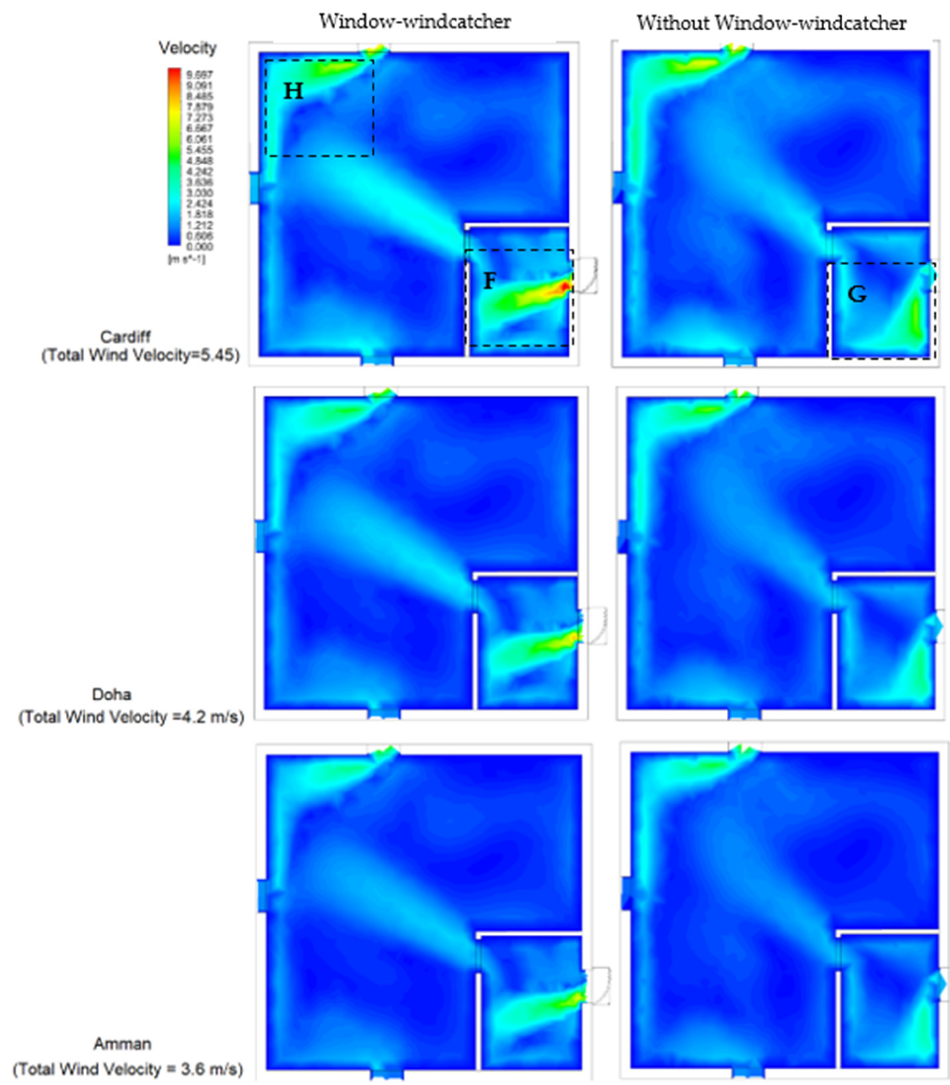
Figure 11. Velocity profile at the 1 m interior plane (H, F and G: High-velocity regions).